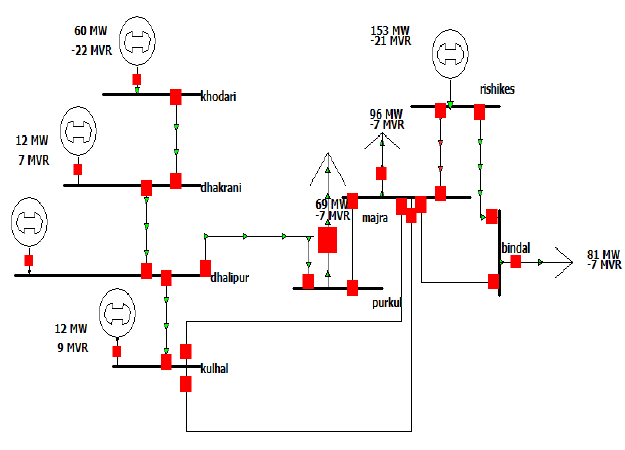
Fig.12 Overloaded system after first iteration